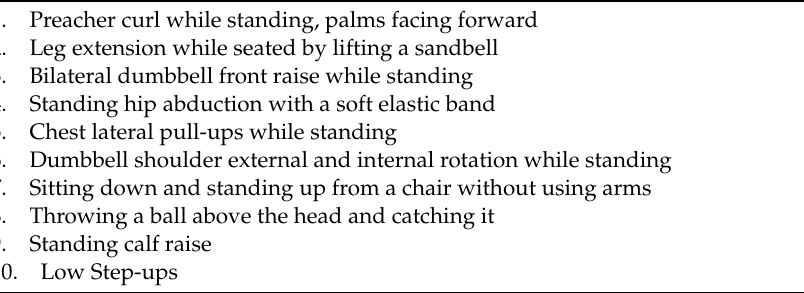
Table 1. 10-exercise circuit included in the physical exercise group